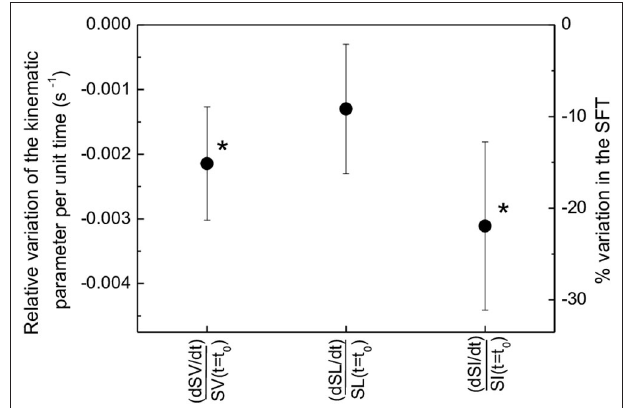
FIGURE 6 | Average relative variation of the kinematic parameters (SV, SL, SI) per unit time in the FST, expressed as linear time derivative of each kinematic parameter ( dSI , dSV , dSL , respectively) normalized to the value of the kinematic dt dt dt parameter at the beginning of the free swimming segment